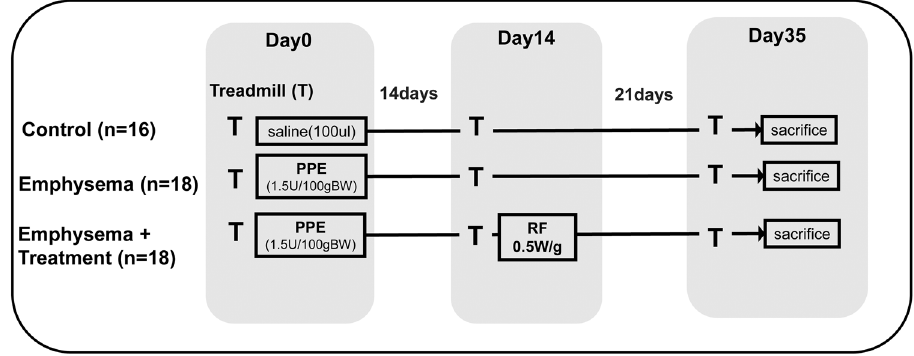
Figure 1. Timeline of the experimental protocol. Fifty-two mice (7 weeks of age) were used in this experiment. We first induced bilateral emphysema in the lungs by instilling porcine pancreatic elastase (PPE) (1.5U/100 g body weight (BW)) into the lungs of mice. Radiofrequency (RF) (0.5 W/ g BW) treatment was then performed two weeks later and mice were sacrificed three weeks post-RF treatment. The exercise capacity of mice was determined on a treadmill test. Treadmill runs were performed just prior to PPE instillation (baseline or day 0), before RF treatment (day 14) and on the day of sacrifice (day 35). Following sacrifice, lung compliance, mean linear intercept (Lm) and fibrosis were